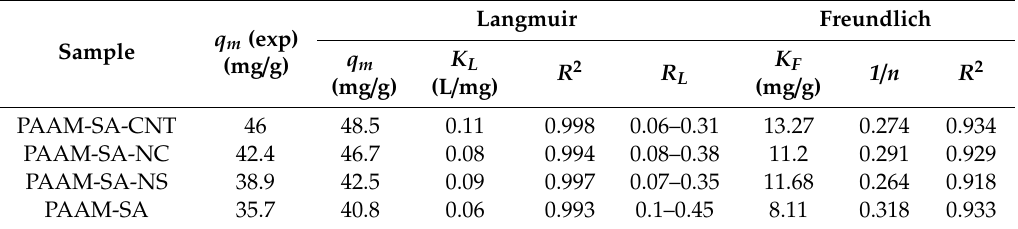
Table 3. Comparison of Langmuir and Freundlich isotherm parameters with experimental adsorption data of Cu 2 + on the hydrogels at 25 ◦ C.